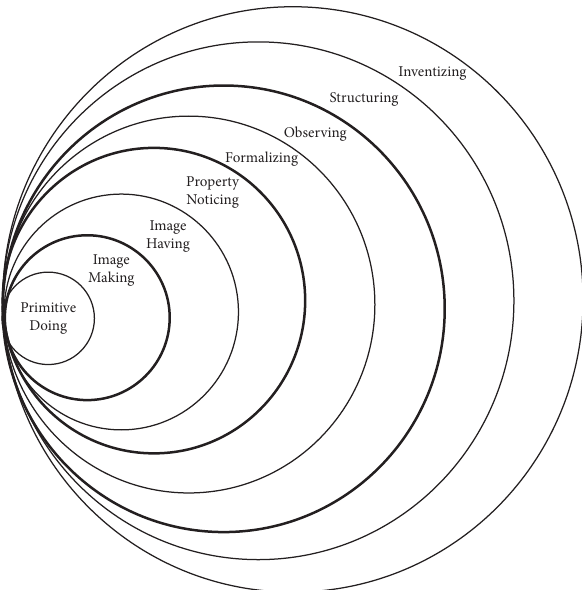
Figure 1: Pirie–Kieren theory of mathematical understanding